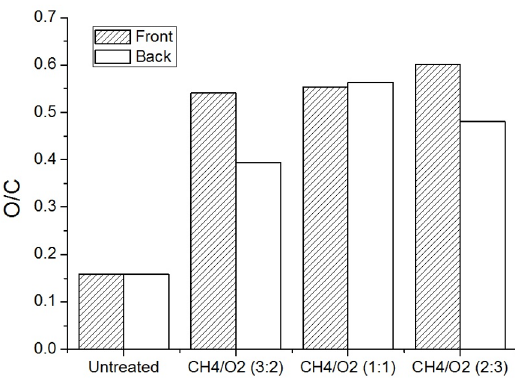
Figure 4. O/C ratio at the surface of the fabric PLA untreated and two sides of the PLA plasma-treated ( front and back ) at different and CH ratios of O 2 4